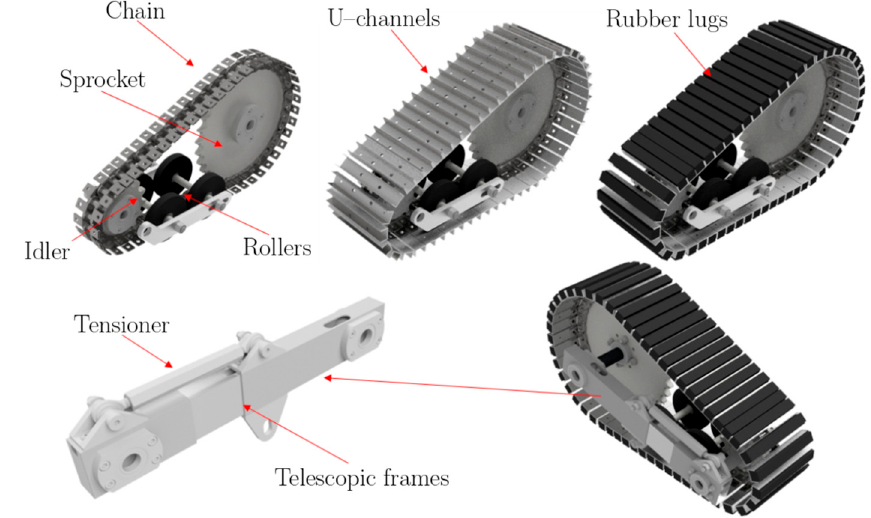
Figure 5. Components of the track module and final assembly.